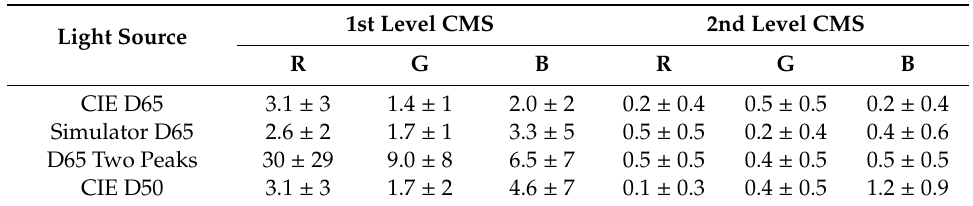
Table 4. Average and standard deviation of the color differences between the calculated and measured RGB colors for the four light sources employed.